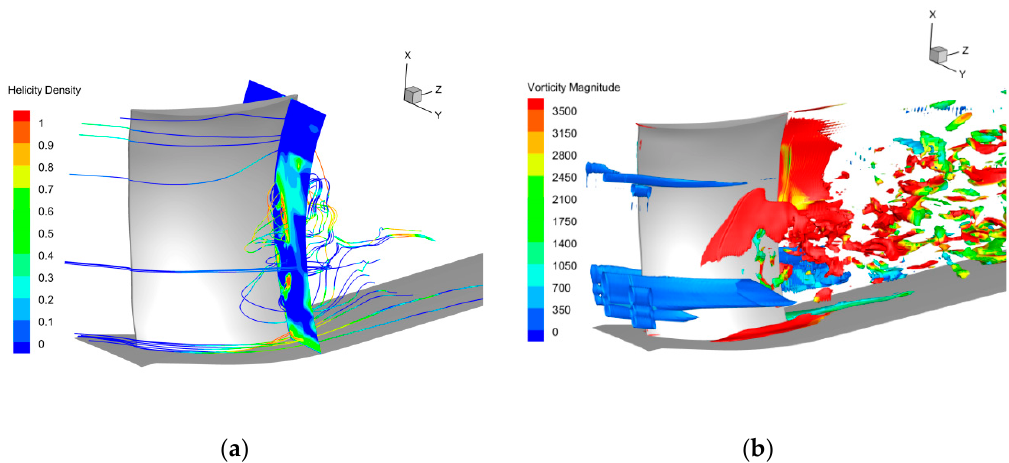
Figure 22. Helicity in the corner separation region: ( a ) contour of helicity density; ( b ) isosurface of helicity density.